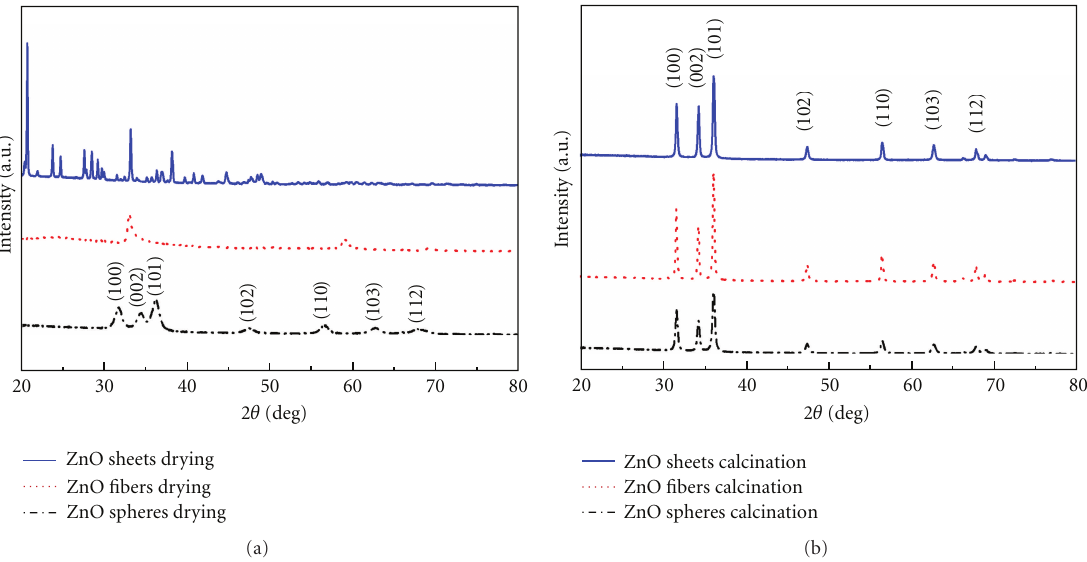
Figure 3: XRD graphs of ZnO fibers, ZnO spheres, and ZnO flakes following (a) drying at 160 ◦ C and (b) calcination at 500 ◦ C.